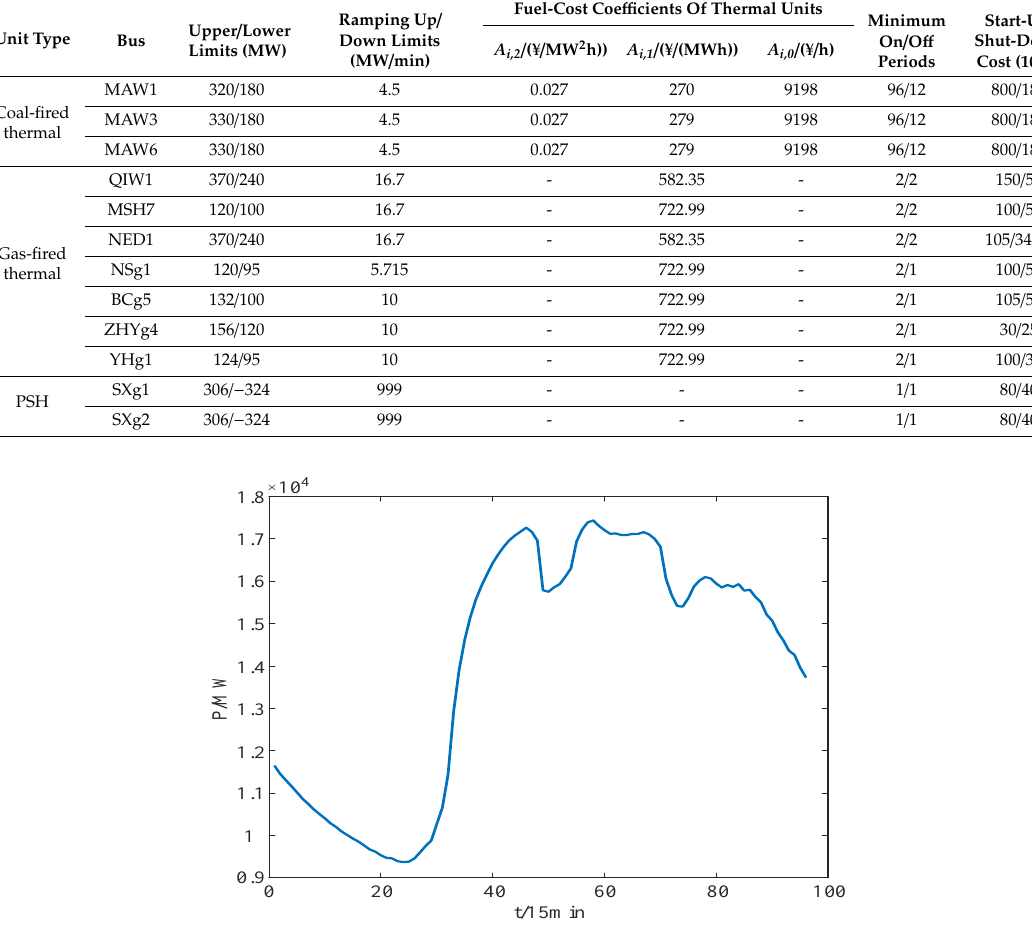
Table 9. Parameters of several units.